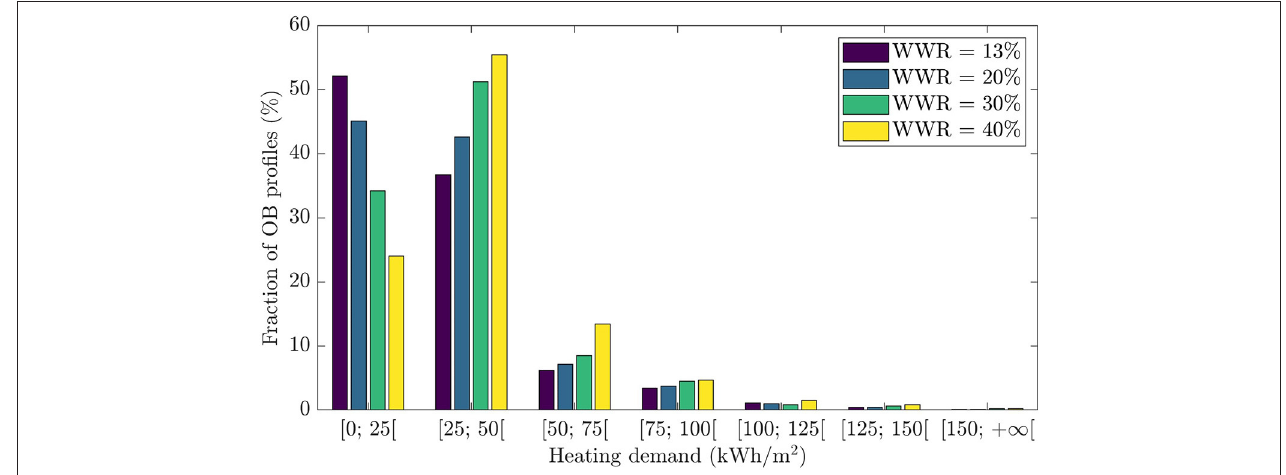
FIGURE 6 | Probability distribution of heating demand depending on occupant behavior.